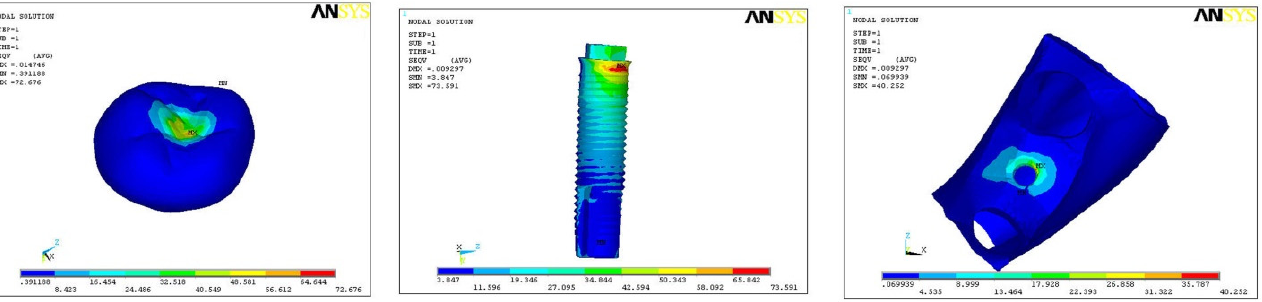
Figure 3. Pattern of stress in model A2.